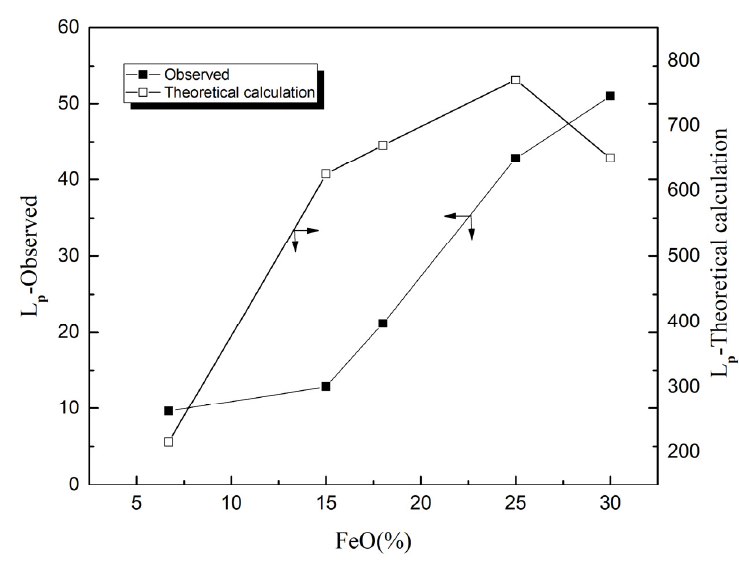
Figure 7. The effect of the Fe t O content on the L p .